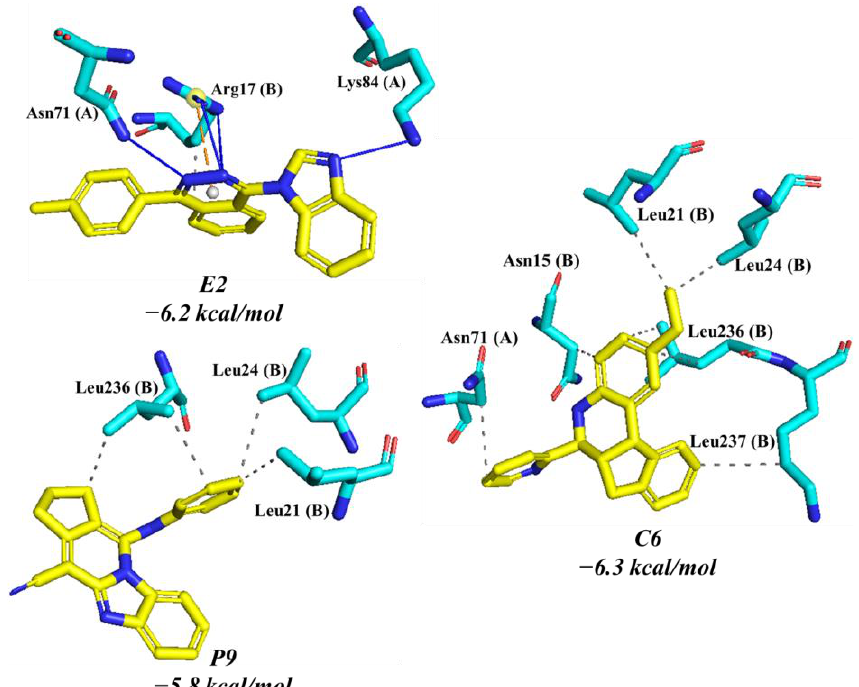
Figure 3. Interaction profile and docking score of compounds C6 , E2 and P9 at the Hs TIM interface. Hydrogen bonds are shown as blue lines, hydrophobic interaction as gray dashed lines, and salt bridge interactions as yellow dashed lines. Interactions were obtained using the PLIP online server.